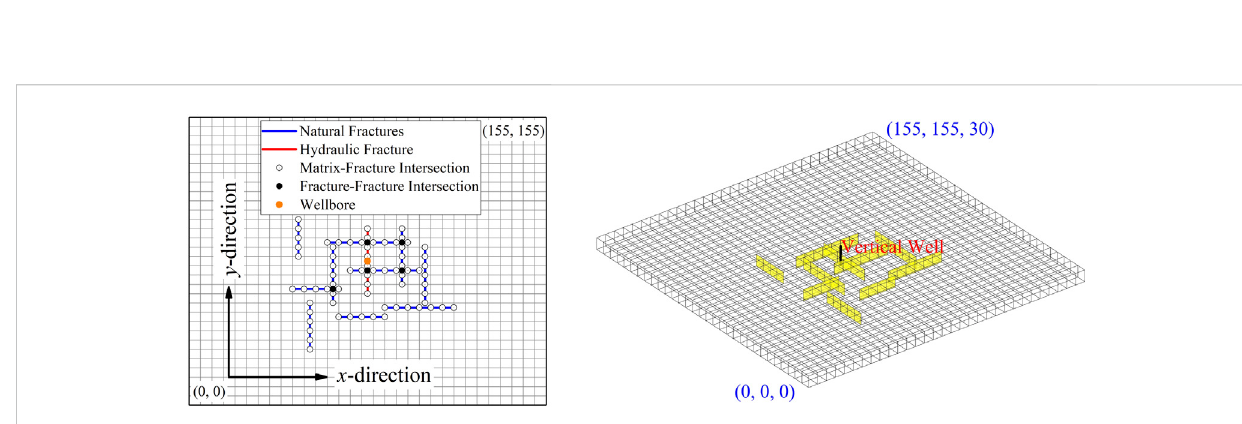
distribution at y =77.5 m on the 1800th production day